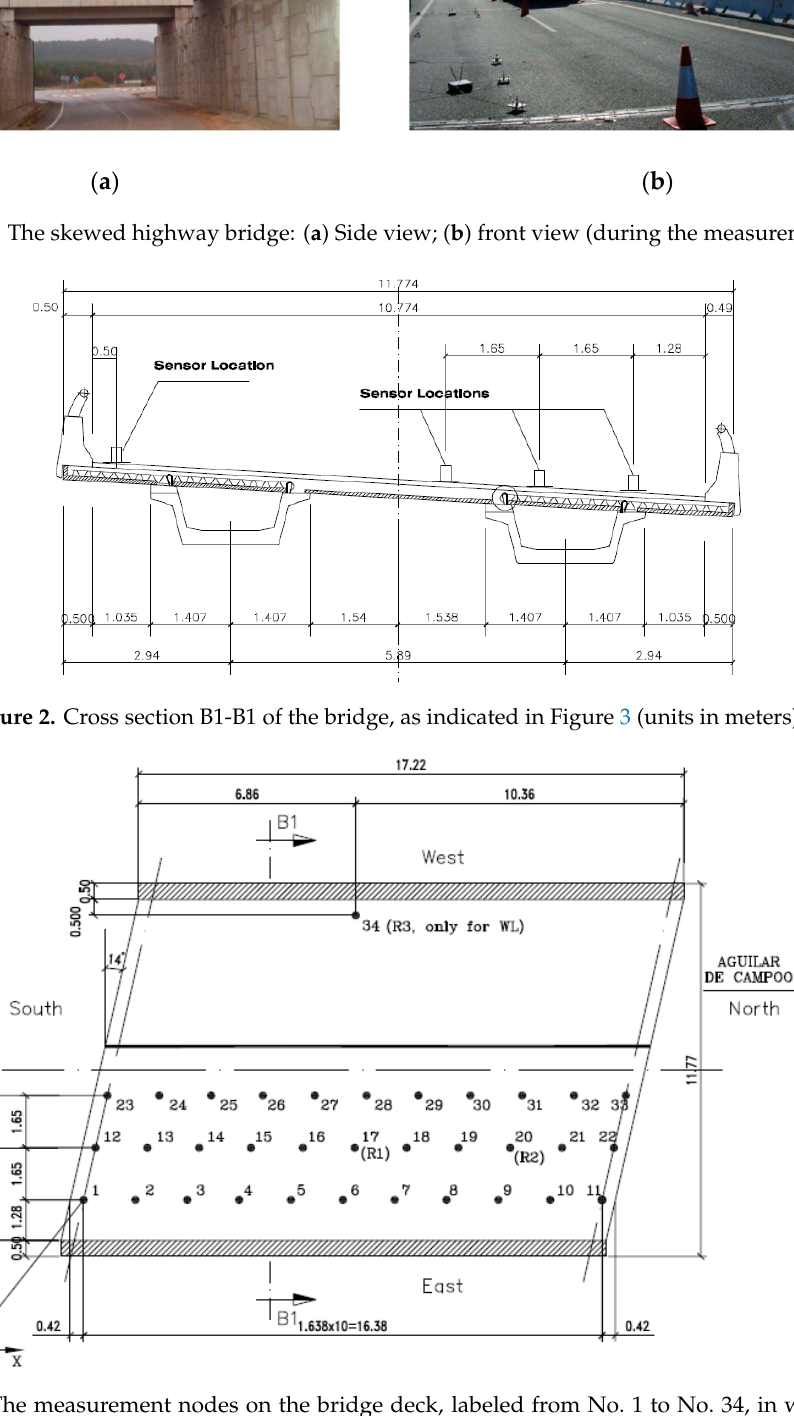
( b ) Figure 4. The wireless sensing system: ( a ) One of the client units; ( b ) server. System identification was carried out by the stochastic subspace identification (SSI) algorithm, as implemented in the MACEC software package [37]. Data processing included the following steps: (1) reduction of the sampling rate of the wireless data from 3906 Hz to 100 Hz; (2) removal of the drift of the signal due to its DC components; (3) removal of the low-frequency noise through a high-pass filter with a cut-off frequency of 2 Hz. For the covariance-driven SSI algorithm, the algorithmic parameter i—half the number of block rows—is set to 180. The system identification is performed for the state-space systems sequentially in orders from 2 to 250. In the corresponding stabilization